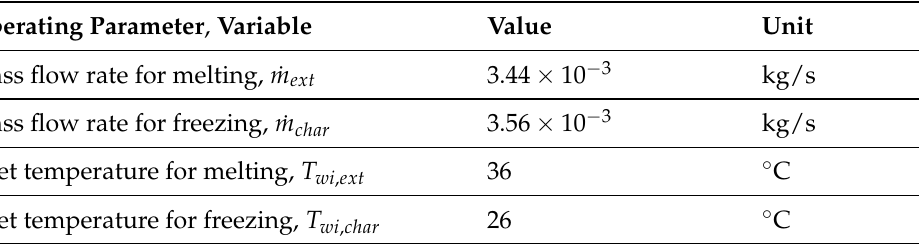
Table 6. Thermal Energy Storage Experimental